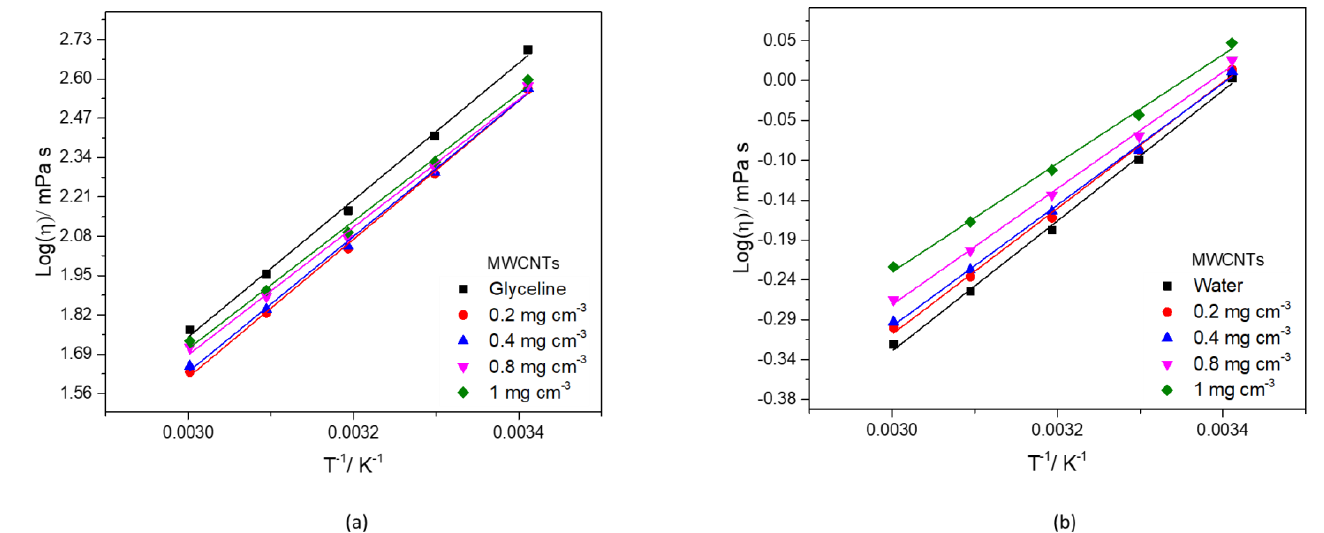
Figure 5. Plot of the logarithm of the viscosities against the reciprocal value of the absolute tempera- ture for glyceline ( a ) and water ( b ) containing MWCNTs with different concentrations. Table 4 and Table 5 list the values of ln (η 0 ) (interception), E η /R (slope), and the re- gression coefficient (R 2 ) the model for viscosity/temperature in glyceline and water. Table 4. Viscosity–temperature model parameters for MWCNTs dispersed in glyceline.